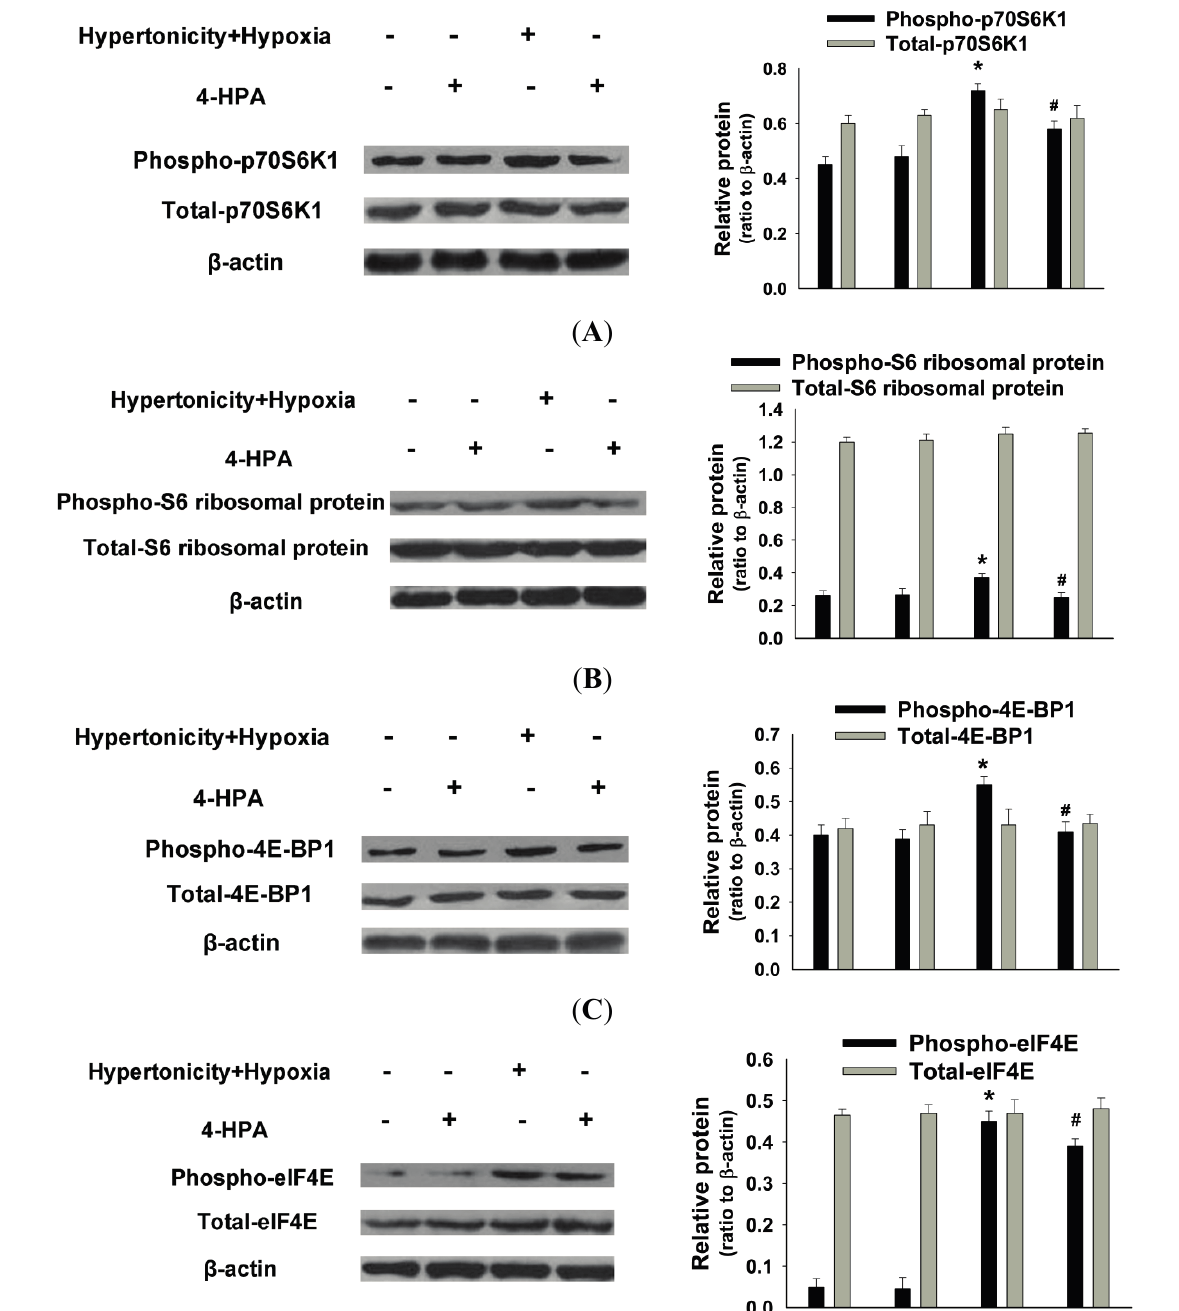
Figure 6. Effects of 4-HPA on HIF-1 α related protein translational regulators under hypertonicity and hypoxia condition s in primary AEC. Primary AEC were treated by hypertonicity and hypoxia in the absence or presence of 4-HPA for 4 h. Then, the cells were harvested for Western blotting and phosphorylation and total protein levels of HIF-1 α related translational regulators, including p70S6K1 ( A ); S6 ribosomal protein ( B ); 4E-BP1 ( C ); and eIF4E ( D ) were detected. The ratios of HIF-1 α related translational regulators to β -actin in protein levels from three independent experiments were obtained by density scanning of the Western blotting. Data are means ± SD, * p < 0.05 vs. control group, # p < 0.05 vs. hypertonicity + hypoxia